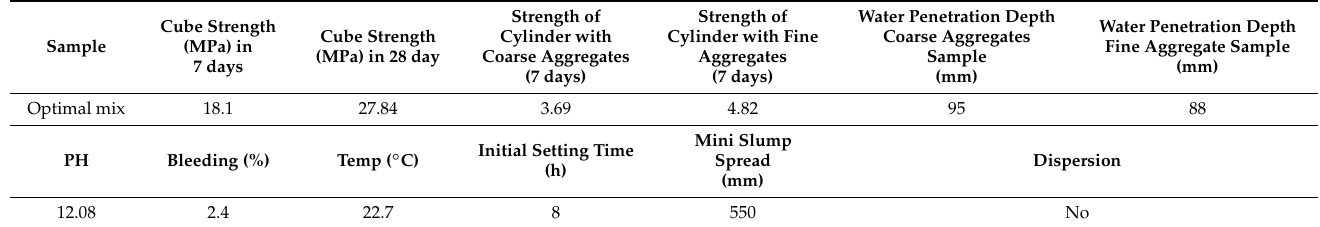
Table 13. Results for the confirmatory optimal